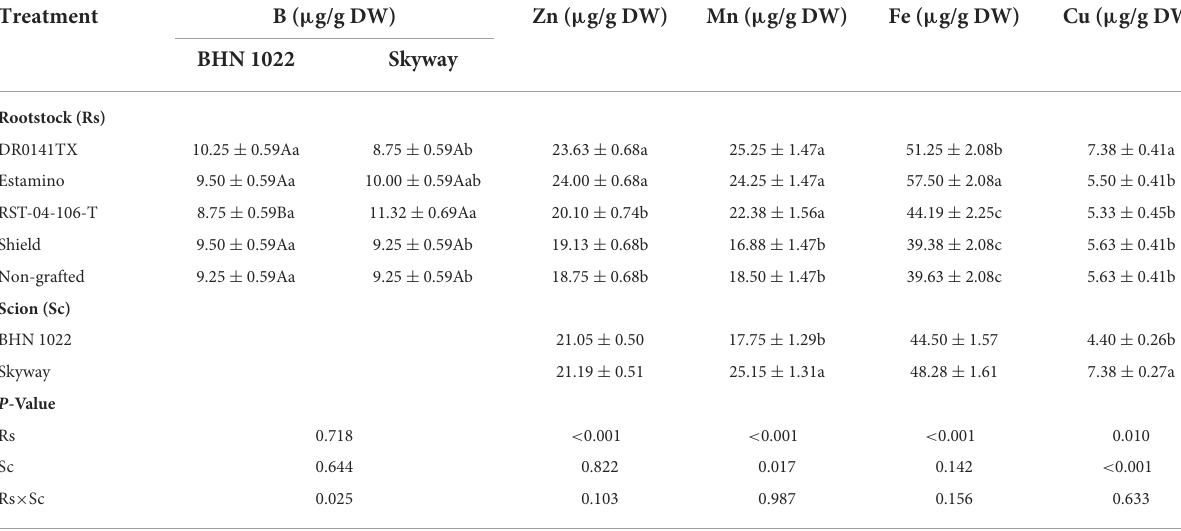
TABLE 10 Fruit micronutrient content on a dry weight basis in grafted tomatoes as affected by rootstock and scion cultivars in the fall planting (24 September 2020 to 15 April 2021). Treatment